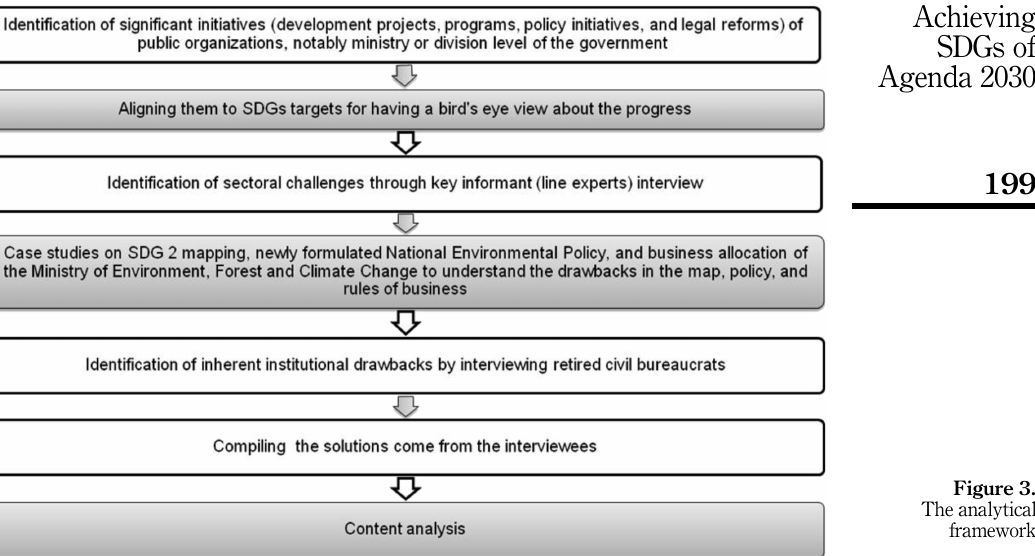
Figure 3. The analytical